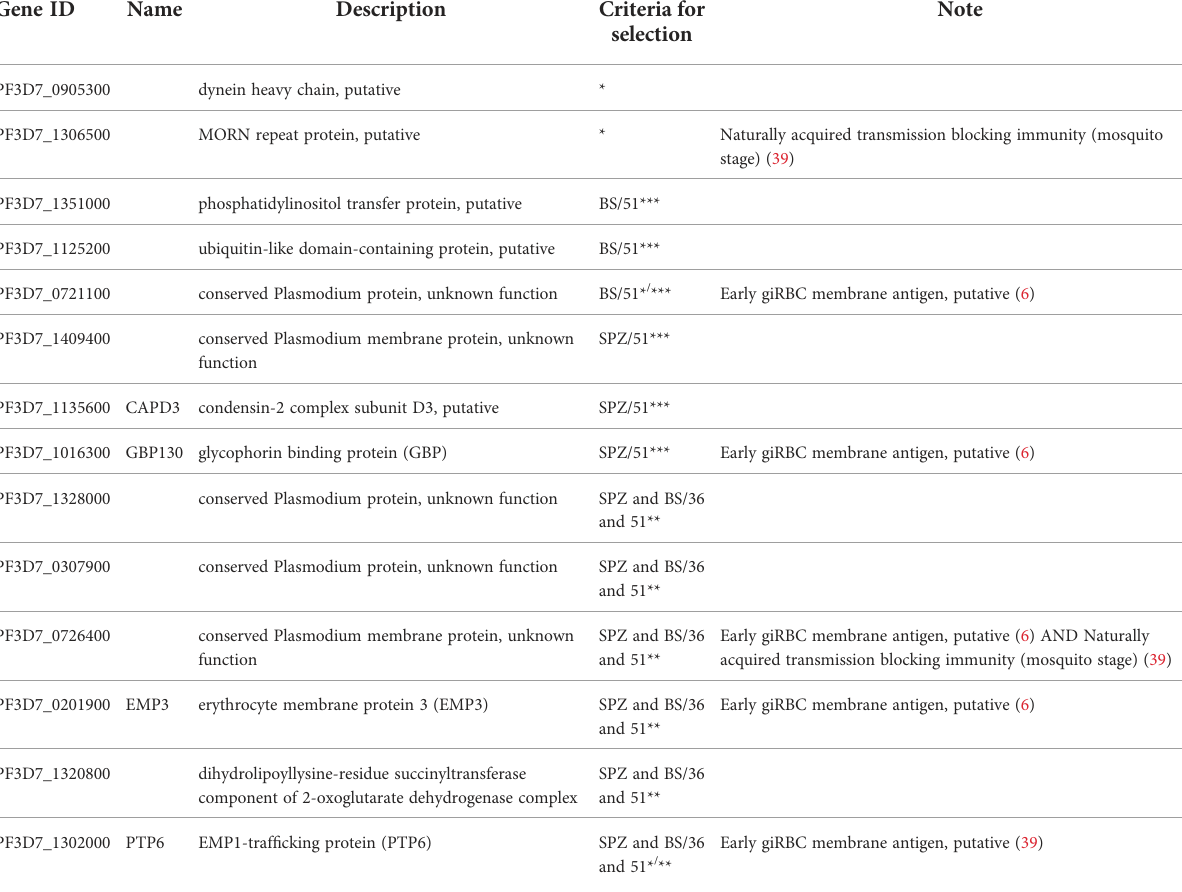
Summary table listing targets with signi fi cantly higher antibody responses (day C+36 and/or 51) compared to baseline in BS Gct but not SPZ Gct (*n=4), in both SPZ Gct and BS Gct comparedtotheirmethodologicalcontrol cohorts(**n=6),andineitherSPZGct orBSGct wherearesponsewasobservedatC+51butnotatC+36(***n=6[overlapping]). BS= Antibody response in blood stage infection cohort, SPZ = Antibody response in sporozoite infection cohort, 36 = Antibody response at C+36 compared to methodology matched control, 51 = Antibody response at C+51 compared to methodology matched control. Full details of these targets and all targets described in the text are given in Supplemental Table